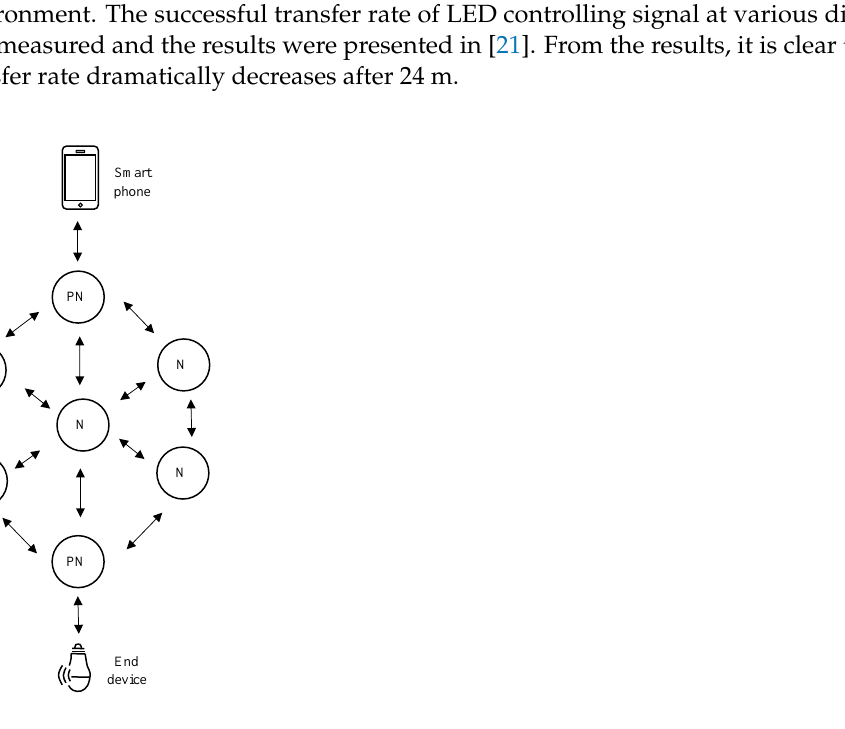
Figure 4. The concept of the data communication network presented in [21], where “N” and “PN” denote a node and a proxy node,